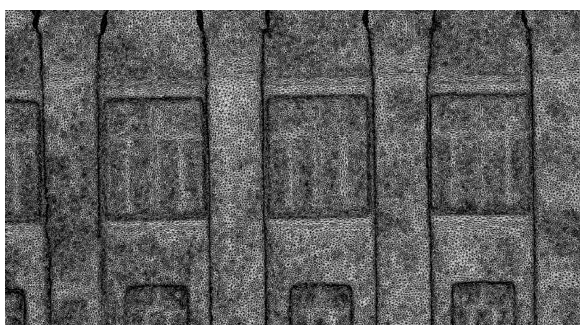
Figure 3. The three-dimensional façade model from images As can be seen from Fig. 3, while creating a vector model from a point cloud, its edges and oblique angles are smoothed out (blurred), for example, the corners of window embrasures and the edges of columns. The vector model was also created using TLS data (Fig. 4) and Leica Cyclone software (Fig. 5).